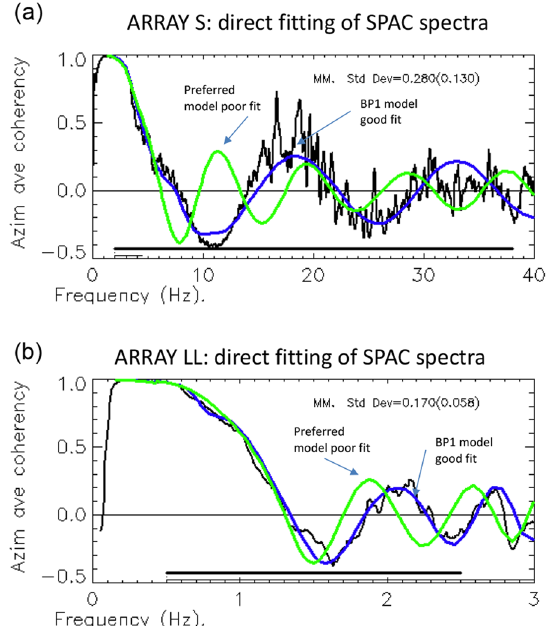
Fig. 5 a SPAC spectra for Preferred model compared with BP1 model, for station separation 10 m. Black: observed SPAC; Green: Preferred model effective mode; Blue: BP1 model effective mode. Standard deviation of fit computed over frequencies 2–38 Hz shows: Std dev for Preferred model is poor; 0.28, Std dev for BP1 model is fair; 0.13 b SPAC spectra for Preferred model compared with BP1 model, for station separation 277 m. Colors as for ( a ) Standard deviation of fit computed over frequencies 0.5–2.5 Hz shows: Std dev for Preferred model is poor; 0.17, Std dev for BP1 model is good; 0.06